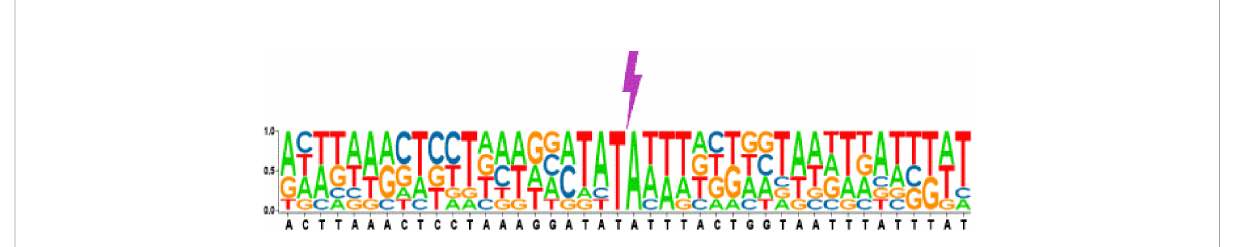
FIGURE 2 Reinsertion preference analysis of excised Ppmar2NA . The pictogram shows the relative nucleotide frequencies of the 7 detected insertion events in the yeast genome. On either side of the reinserted Ppmar2NA elements, 20 bases fl ank the conserved TA insertion spot. The nucleotide A is shown in green, C in red, G in blue, and T in yellow. The lightning symbol indicates the Ppmar2NA reinsertion